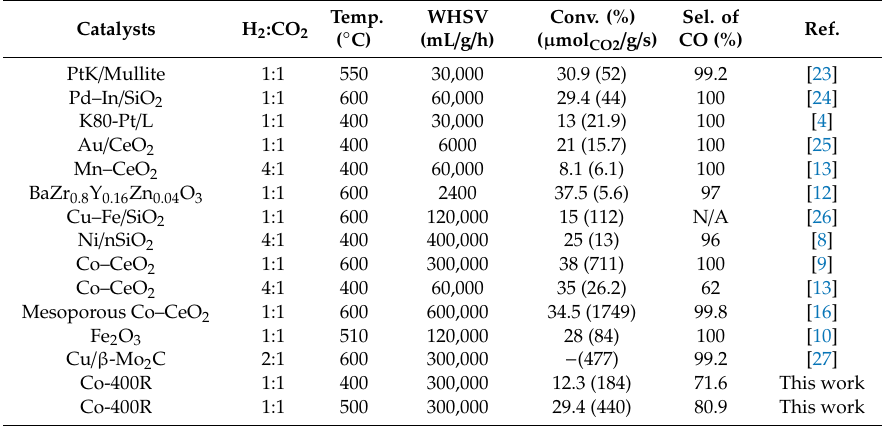
Table 1. Comparison of reverse water–gas shift (RWGS) reaction rate and CO selectivity for the NP-Co and literature-reported